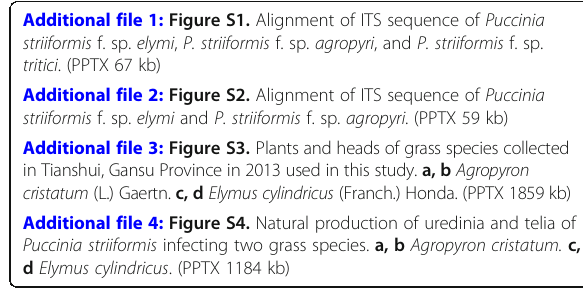
Additional file 3: Figure S3. Plants and heads of grass species collected in Tianshui, Gansu Province in 2013 used in this study. a, b Agropyron cristatum (L.) Gaertn. c, d Elymus cylindricus (Franch.) Honda. (PPTX 1859